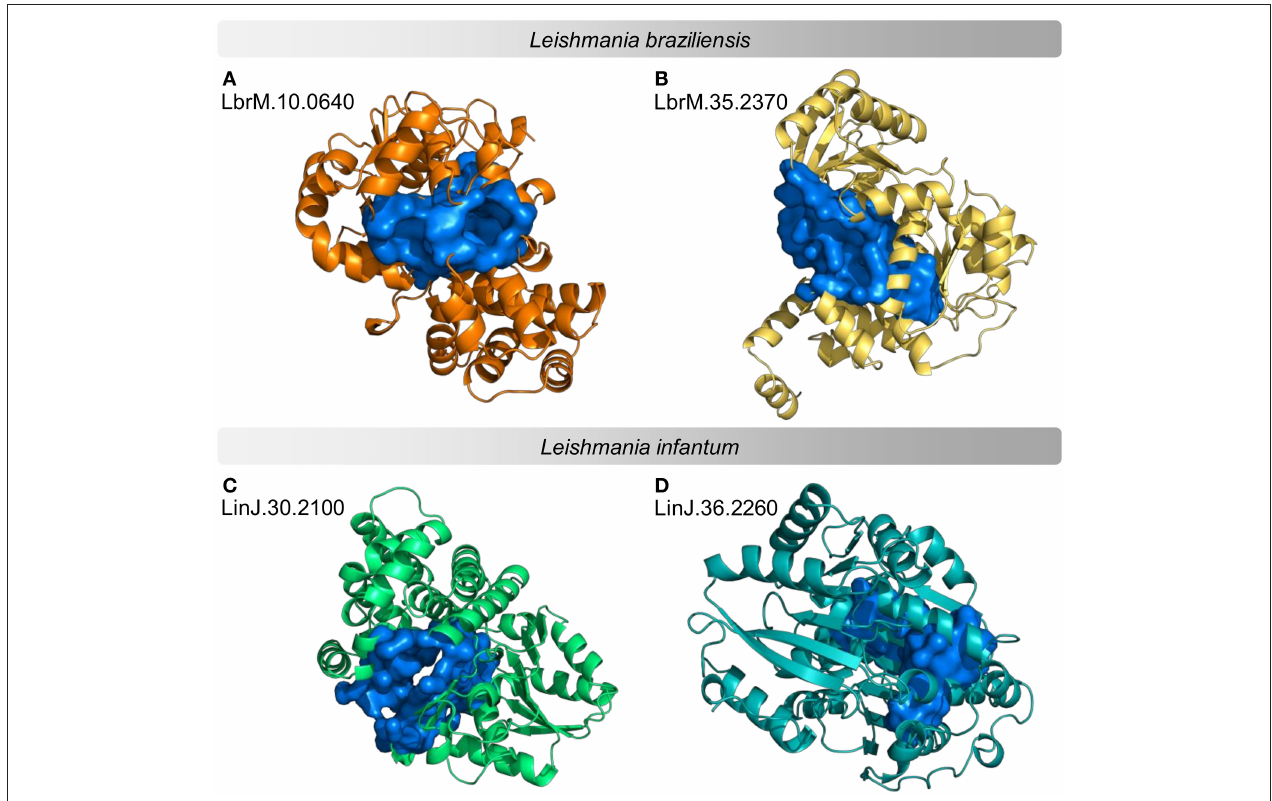
FIGURE 5 | Example of predicted structures and druggable binding sites for potential protein targets in proteomes of Leishmania sp. Predicted three-dimensional conformations associated with a druggable binding site for 4 examples of potential drug targets. (A,B) examples of L. braziliensis proteins (C,D) examples of L. infantum proteins. The structures on the left are examples of druggable proteins with < 50% similarity to the human proteome. The structures on the right are examples of druggable proteins with the highest Neighborhood Connectivity value in the